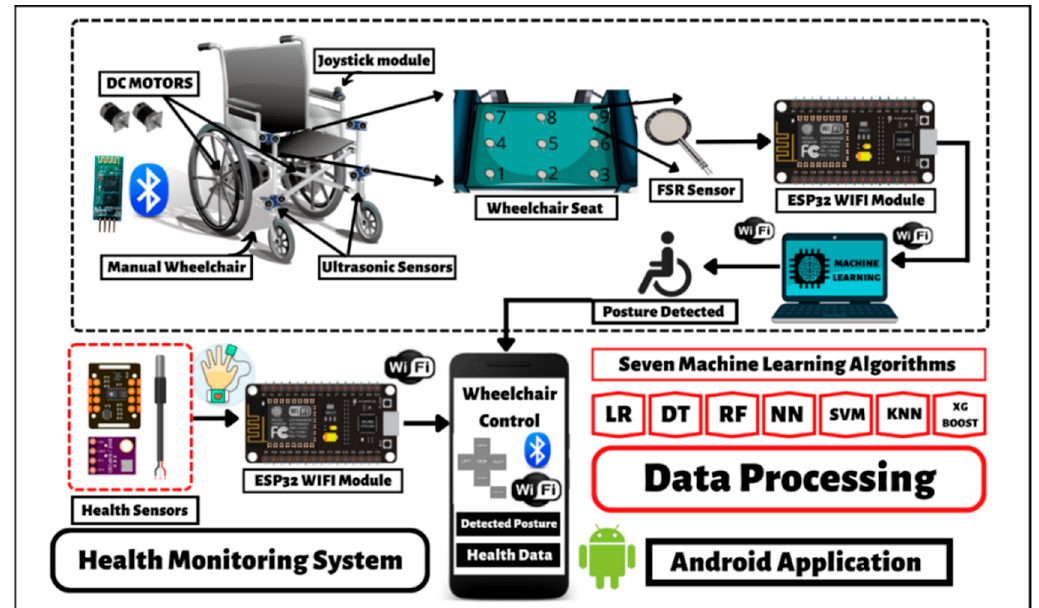
Figure 8. System Overview Diagram including multi-mode electric wheelchair with obstacle detection joystick, app and voice control, IoT-based health monitoring system, and posture detection system using machine learning algorithms and techniques.